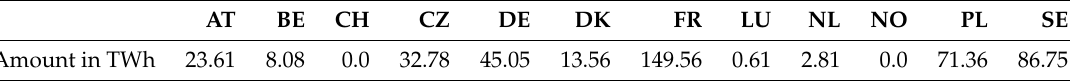
Table A5. Biomass potential of agriculture and forest residue per country in 2050 based on the hotmaps